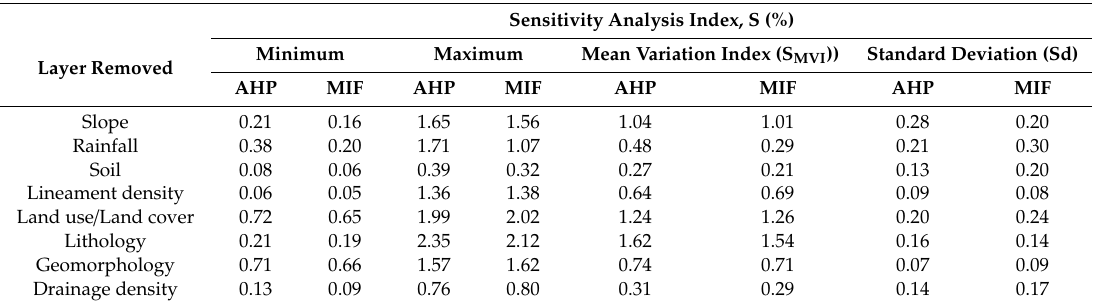
Table 9. Statistics of the sensitivity analysis index